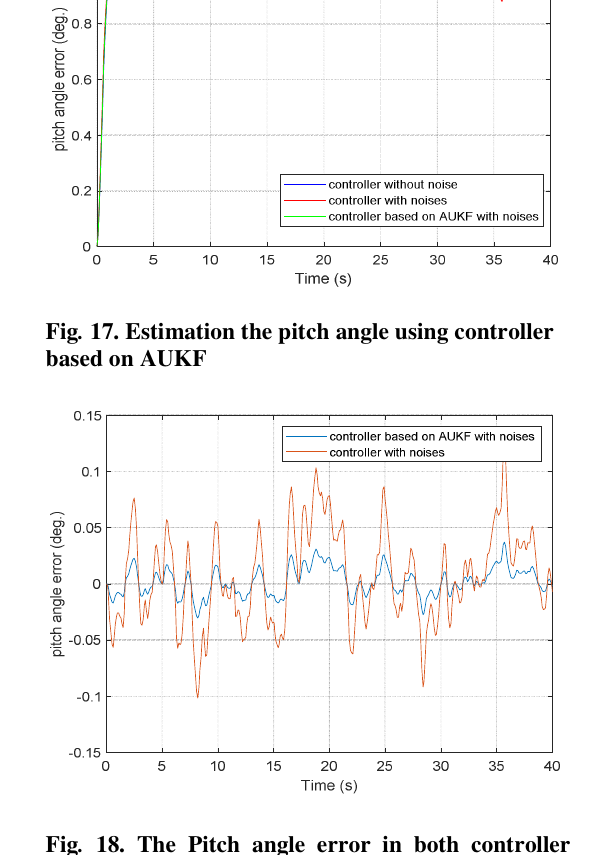
Fig . 18. The Pitch angle error in both controller with and without using